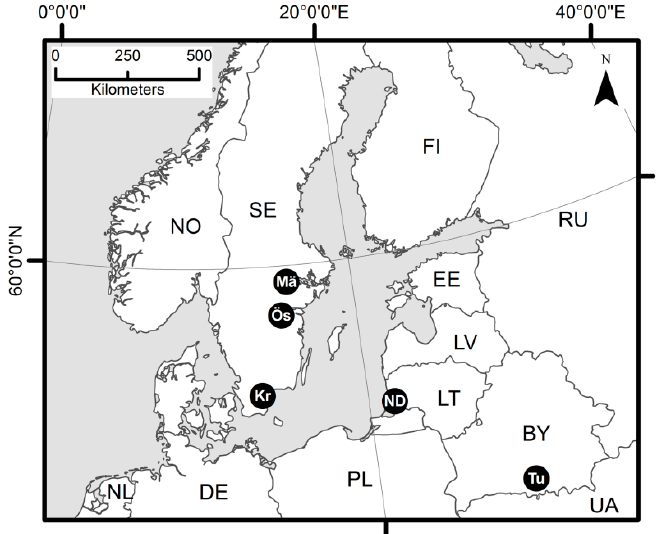
Figure 1. Locations of the five case study landscapes in Sweden (SE) (Kristianstad (Kr), Östergötland (Ös), Mälardalen (Mä)), in Lithuania (LT) (Nemunas Delta (ND)) and in Belarus (BY) (Turov (Tu)).